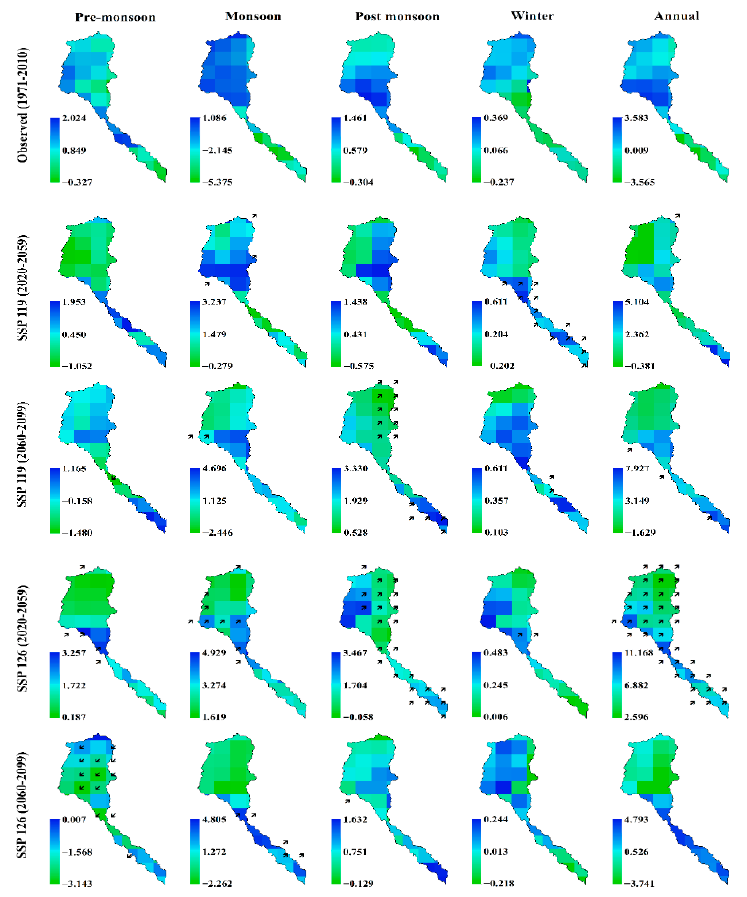
Figure 5. Spatial distribution of trend (significant at 95% confidence level) and magnitude in the seasonal and annual series of precipitation during the observational and future period (tilted upward arrow denotes significant increasing trend and vice versa).